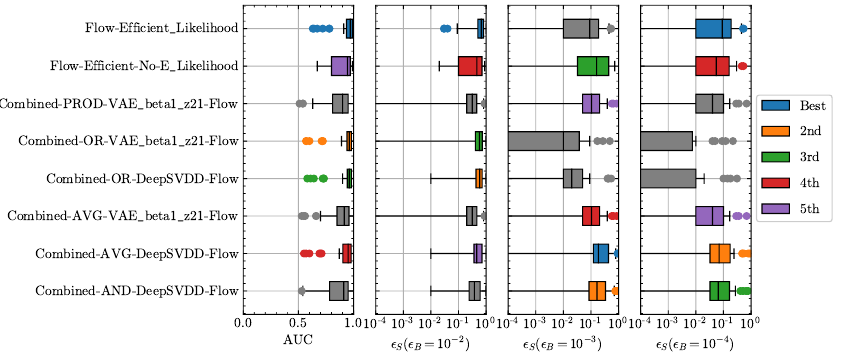
Figure 16: Box plots summarizing the anomaly detection techniques applied to all of the new physics signals. The colors denote the techniques that have the highest median scores for each of the figures of merit.